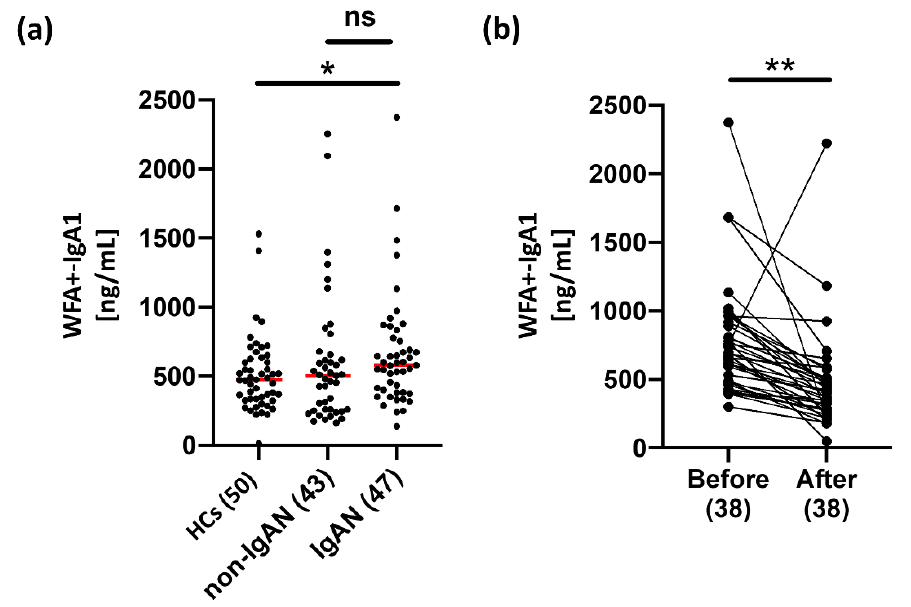
Figure 4. Measurement of serum WFA+-IgA1 levels with automated CLEIA. ( a ) Serum WFA+-IgA1 levels in HCs ( N = 50), non-IgAN patients (N = 43), and IgAN patients ( N = 47). ( b ) Comparison of serum WFA+-IgA1 levels before and after tonsillectomy in IgAN patients ( N = 38). Values that significantly differed between each subject group were identified by the Mann–Whitney U test. The medians of each group are shown as the red bar. * p < 0.05, ** p < 0.01, ns; not significant.